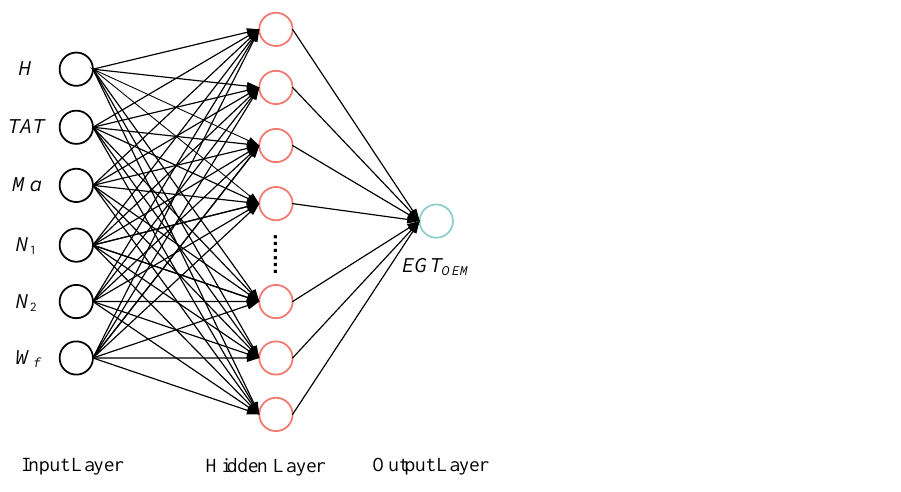
Figure 2. The schematic diagram of the RBF ’s architecture.